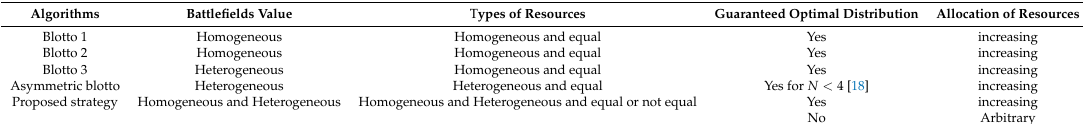
Table 4. Comparative table of the strategies of the literature and that proposed as a